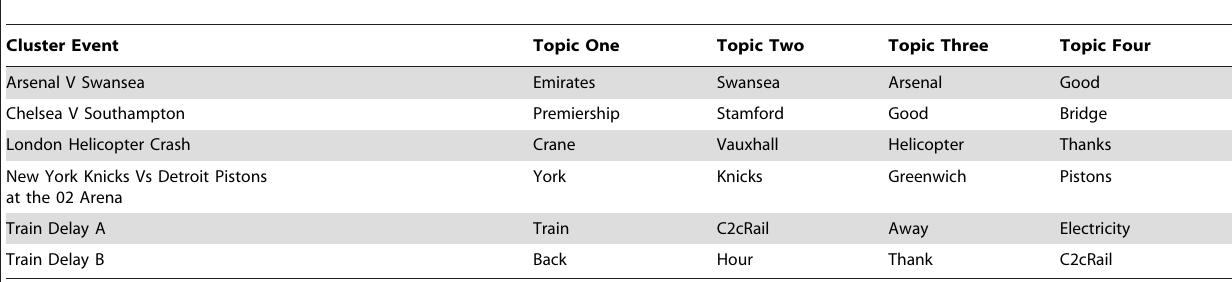
Table 3. Significant clusters identified during daily aggregations using Latent Dirichlet Allocation and their associated topics.